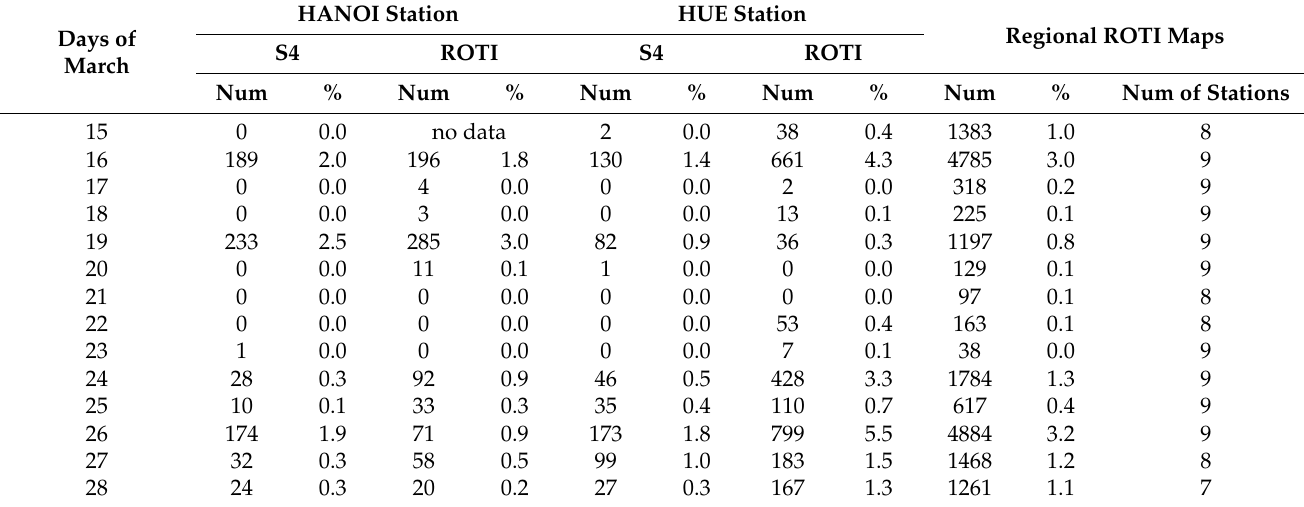
Table 4. Statistics for the S4 and ROTI indices and the ionospheric disturbances derived from the regional ROTI maps during the period of 15–28 March 2015.